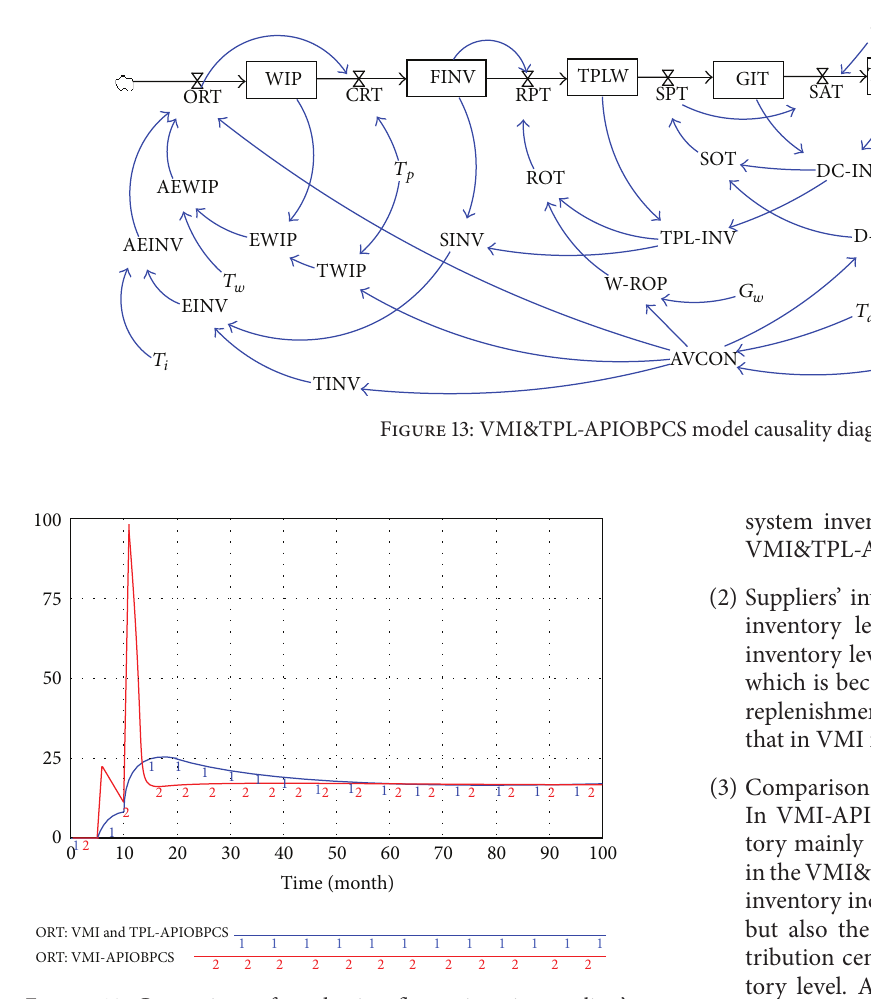
Figure 14: Comparison of production fluctuations in suppliers’ production